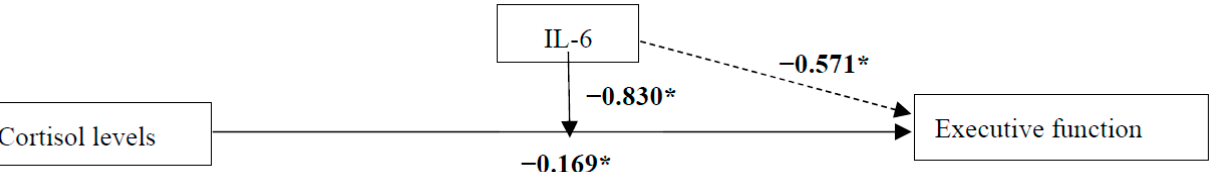
Figure 3. Unstandardized regression coefficients for the relationship between cortisol levels and executive function with moderators IL-6 and diagnostic group (CNI vs. MCI) in the total sample. Sex, waist circumference, depression diagnosis, and performance in a receptive vocabulary task, as a measure of educational level, were included as confounders in all models. * p ≤ 0.05; *** p ≤ 0.001 . 3. Results 3.1. Is the Relation of Basal Cortisol Levels with Executive Function Moderated by IL-6 Levels? The relation of basal cortisol levels with executive function was moderated by IL-6 levels in the total sample [ b = − 0.830, 95% CI [ − 1.505, − 0.155], t (171) = − 2.428, p = 0.016]. This effect was only significant among participants with higher IL-6 levels [ b = − 0.229, 95% CI [ − 0.599, − 0.120], t (171) = − 2.960, p = 0.004], not those with moderate or lower IL-6 levels (all p > 0.138). Additionally, the regression coefficients between cortisol levels and execu- tive function [ b = − 0.169, 95% CI [ − 0.330, − 0.009], t (171) = − 2.078, p = 0.039], as well as be- tween IL-6 levels and executive function, were statistically significant [ b = − 0.571, 95% CI [ − 1.105, − 0.038], t (171) = − 2.115, p = 0.036]. Among the covariates, only the performance in the receptive vocabulary task was statistically significant [ b = 0.037, 95% CI [0.019, 0.054], t (171) =4.069, p < 0.001]. 3.2. Is the Moderation by IL-6 Levels of the Relation of Basal Cortisol Levels with Executive Function Moderated by Diagnostic Group (CNI vs. MCI)? In the total sample, the relation of basal cortisol levels with executive function was moderated by IL-6 levels [ b = − 0.994, 95% CI [ − 1.961, − 0.027], t (167) = − 2.029, p = 0.044] and diagnostic group separately [ b = − 0.632 s, 95% CI [ − 0.901, − 0.363], t (167) = − 4.643, p < 0.001]. Moreover, there was an interaction of cortisol levels and diagnostic group with executive function [ b = − 0.562, 95% CI [ − 0.872, − 0.253], t (167) = − 3.590, p < 0.001], but no other inter- actions between IL-6 levels and diagnostic group, and cortisol and IL-6 levels and diag- nostic group with executive function performance (all p > 0.644). In the sub-group of CNI participants, there were no statistically significant effects on or interaction of cortisol and IL-6 levels with executive function (all p < 0.157). In the sub- group of MCI participants, however, the interaction between cortisol levels and executive function was statistically significant [ b = − 0.420, 95% CI [ − 0.640, − 0.200], t (88) = − 3.795, p < 0.001]. There were no other statistically significant effects or interactions (all p > 108).